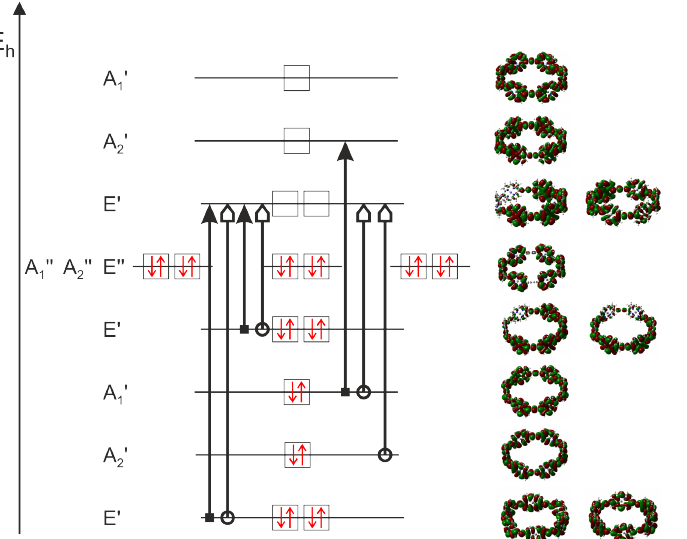
Figure 5. Sketches of orbitals close to the Fermi level for c-P6 6 + . Rotation- and translation-allowed virtual transitions are indicated with arrows terminated with a circle or a square, respectively. Only one of the six antisymmetric inactive orbitals A (cid:48)(cid:48)